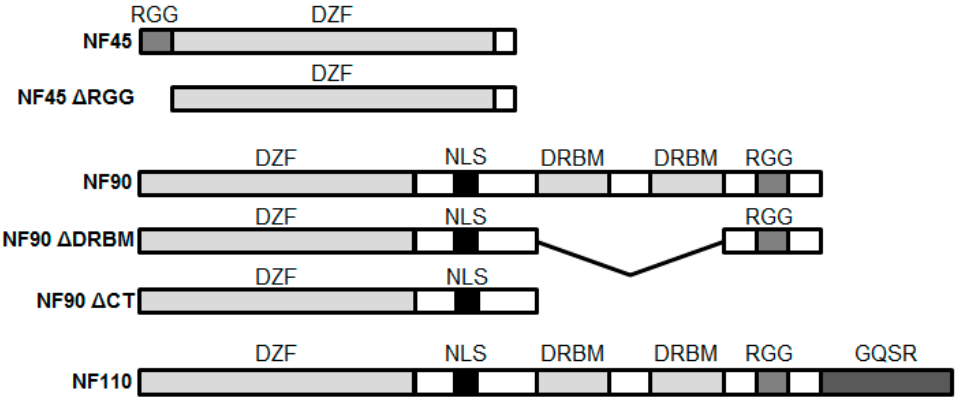
Figure 1. Schematic structure of NF45, NF90, NF110 and the mutants used in this study. Domain abbreviations include: RGG, arginine-glycine-glycine domain; DZF, domain associated with zinc fingers; NLS, nuclear localization signal; GQSR motif, glycine, glutamine, serine, arginine motif.